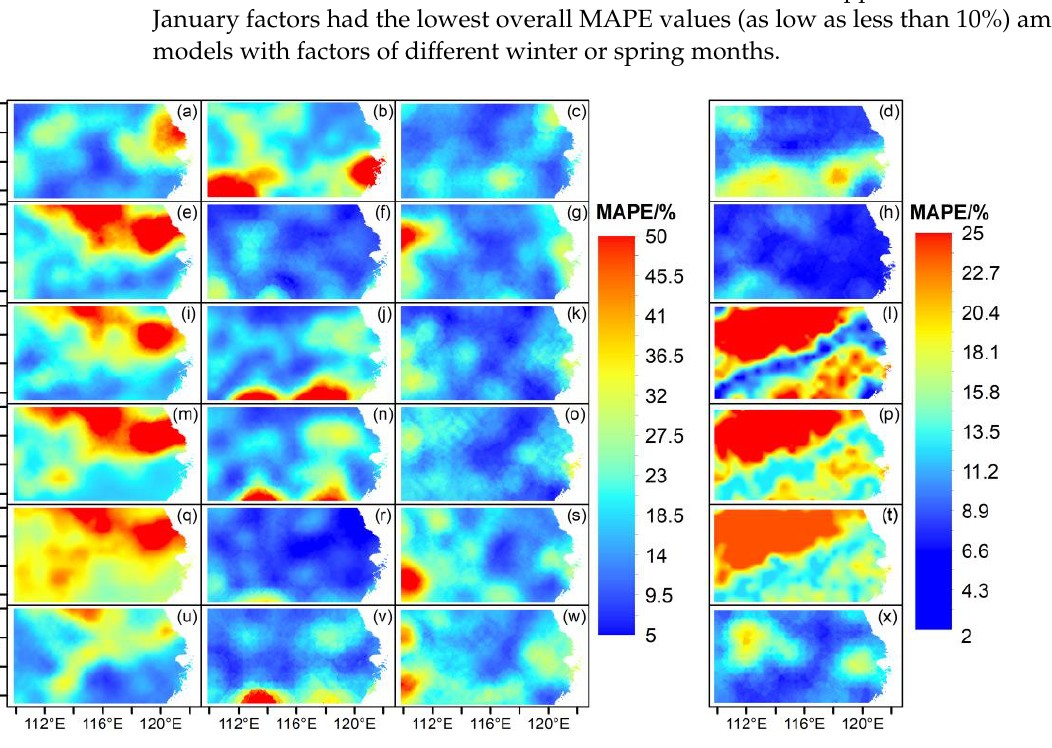
Figure 7. Spatial distributions of MAPE by GABP, where the six rows are for models using the factors of December, January, February, March, April and May (from top to bottom; e.g., ( a – d ) are for December factors), with four columns for the forecasted precipitations of June, July, August and summer (from left to right; e.g., ( b , f , j , n , r , v ) are for July precipitations), respectively. It can be observed from Figure 8 and Table 1 that most of the basin-averaged AR values of 18 GABP models for single months exceed 50%, which indicates the reliability of the precipitation forecasts. The summer AR (i.e., the right column in Figure 8) shows good whereas the model using January factors is the best with an AR of 88.3% (Figure 8h; Table 2). correspond to larger AR values (e.g., for summer forecasts in the right columns of MAPE and AR; Figure 7d,h,l,p,s,t,v,x; Figure